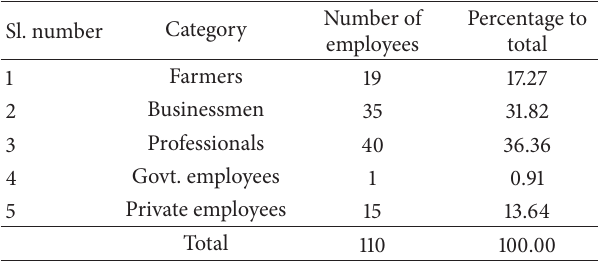
Table 2: Category of customers